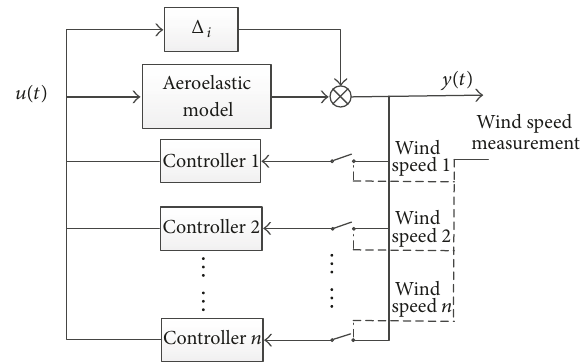
Figure 5: Switching controller model of uncertain